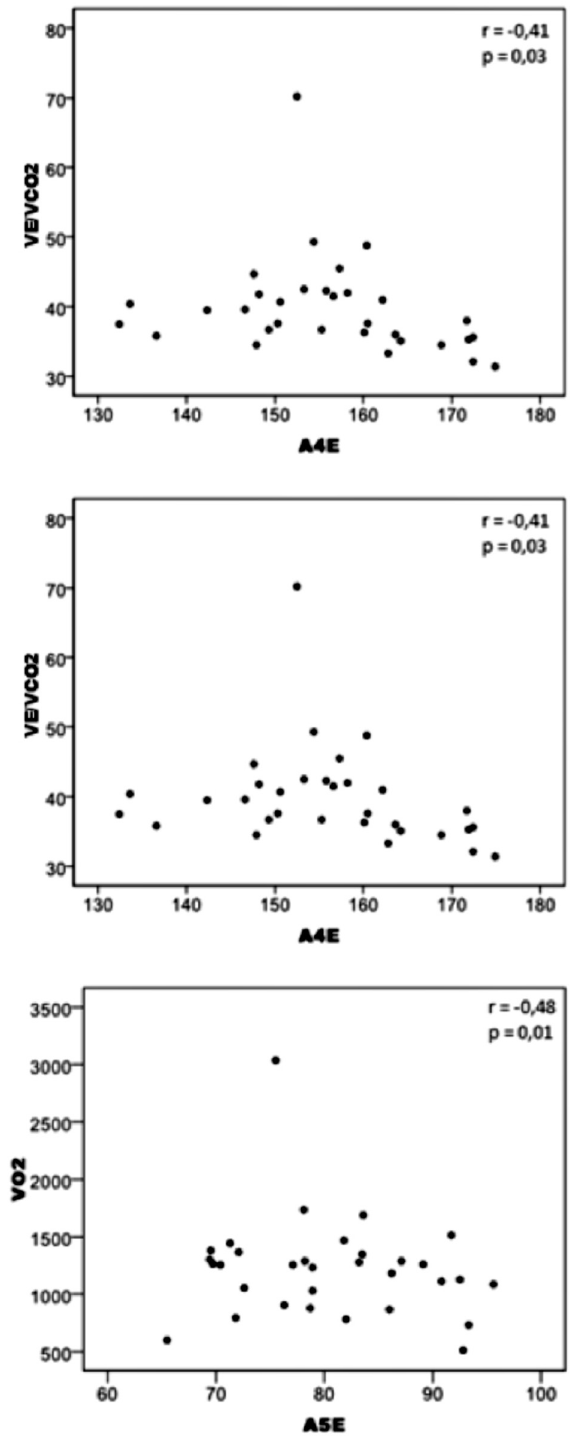
Figure 3 - Correlation between te angles obtainded by photogrammetry and metabolic and ventilatory